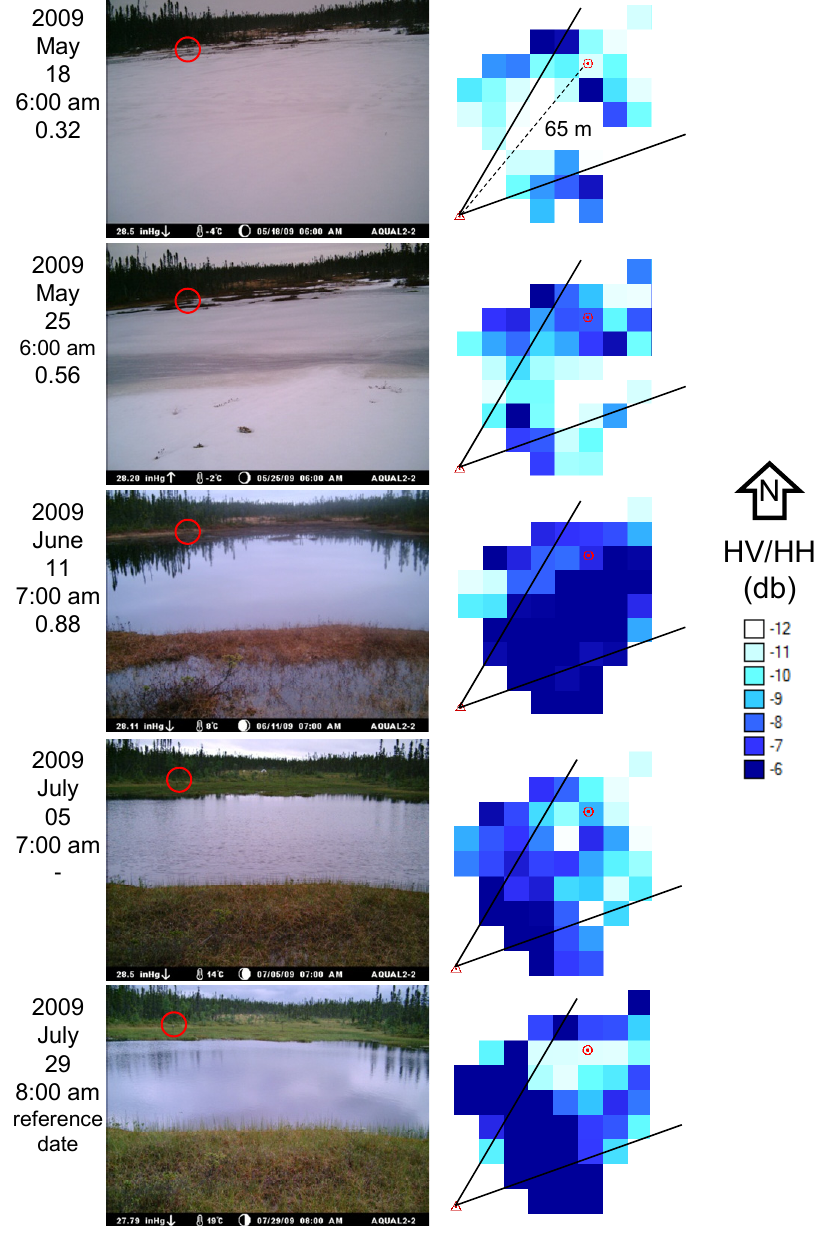
measured volumetric soil moisture in m 3 ·m − 3 ; red circle: FDR probe); to the right of the figure: pseudo-color representation of the cross-polarization ratio for the corresponding dates and time of ground photos (red circle = FDR probe; red triangle = ground camera; black lines = estimated perspective of the ground photos).